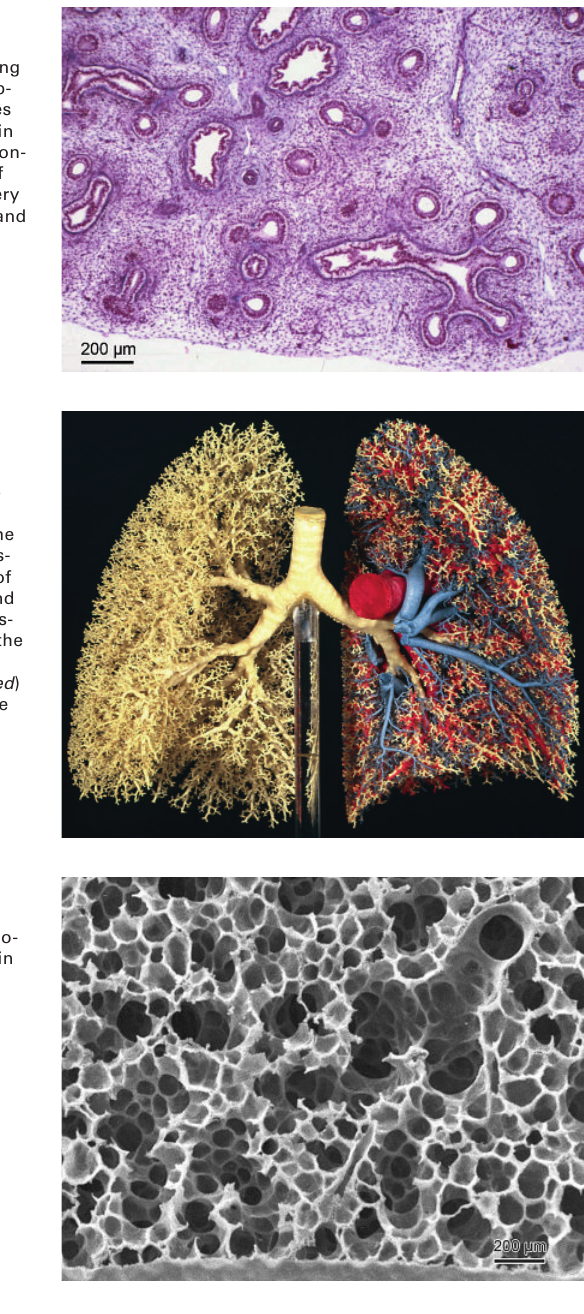
Section of foetal human lung showing the branching of ep- ithelial airway tubes by dichotomy within the mesenchyme con- taining branches of the pulmonary artery (close to airways) and veins (in septa).